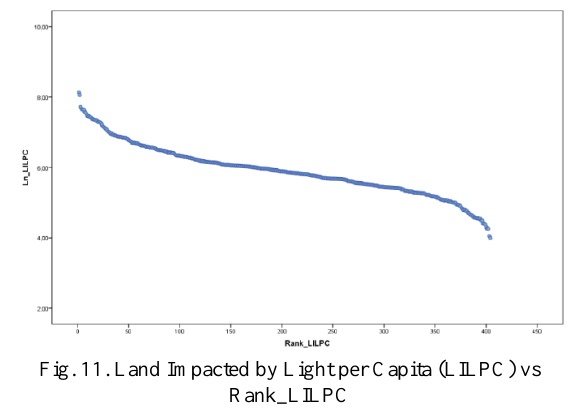
Fig. 11. Land Impacted by Light per Capita (LILPC) vs Rank_LILPC